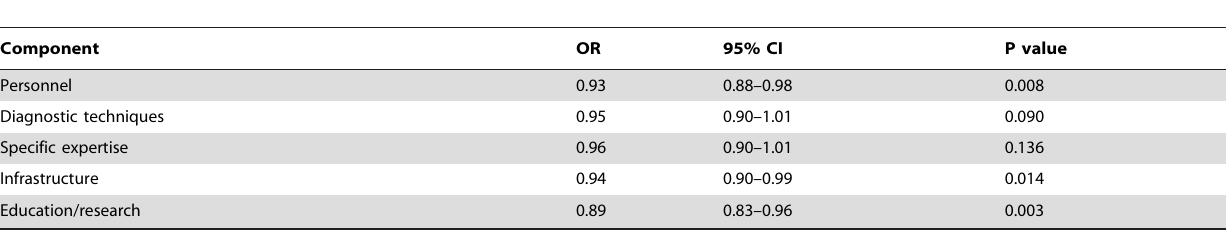
Table 7. The impact of subcategory CSC score on in-hospital mortality after ischemic stroke adjusted by age, sex and JCS.